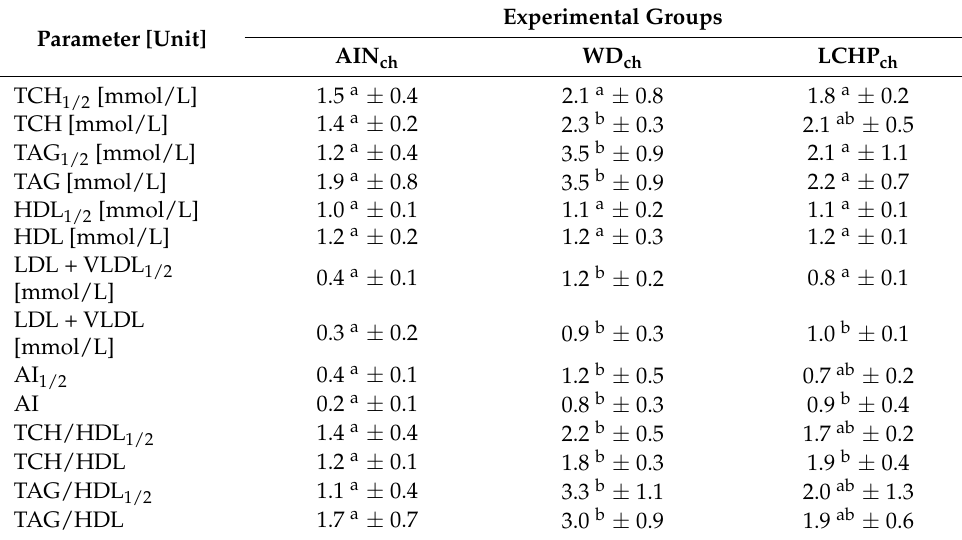
Table 3. Serum lipid profile, atherogenic index, TCH/HDL and TAG/HDL ratios of rats after 4 (marked as 1 ) and 8 weeks of feeding: AIN ch , WD ch (Western diet) or LCHP ch (low-carbohydrate– 2 high-protein) diets, enriched with 1% cholesterol.